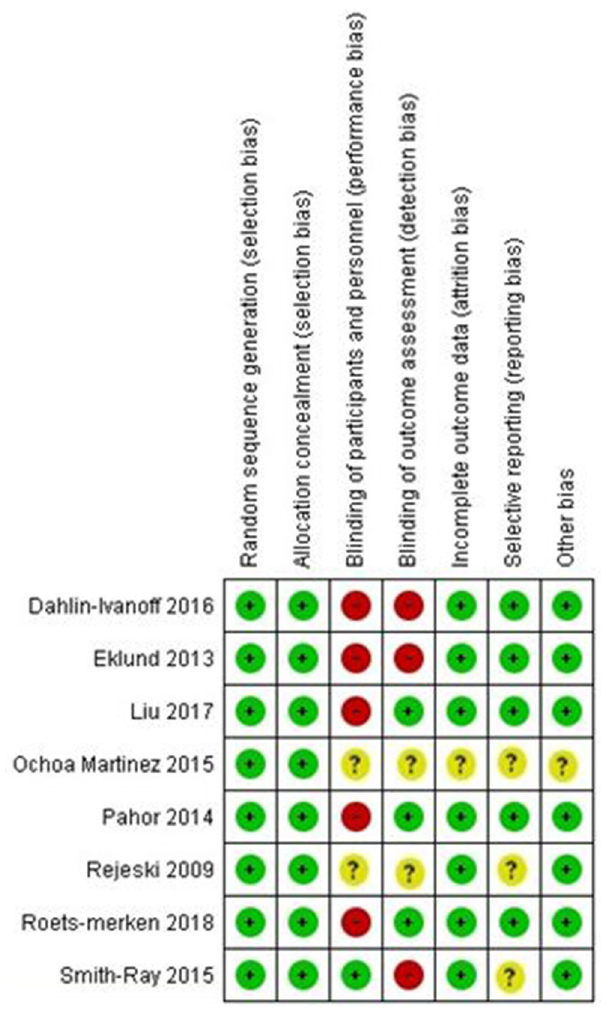
conferences. It should be noted that articles without full text were